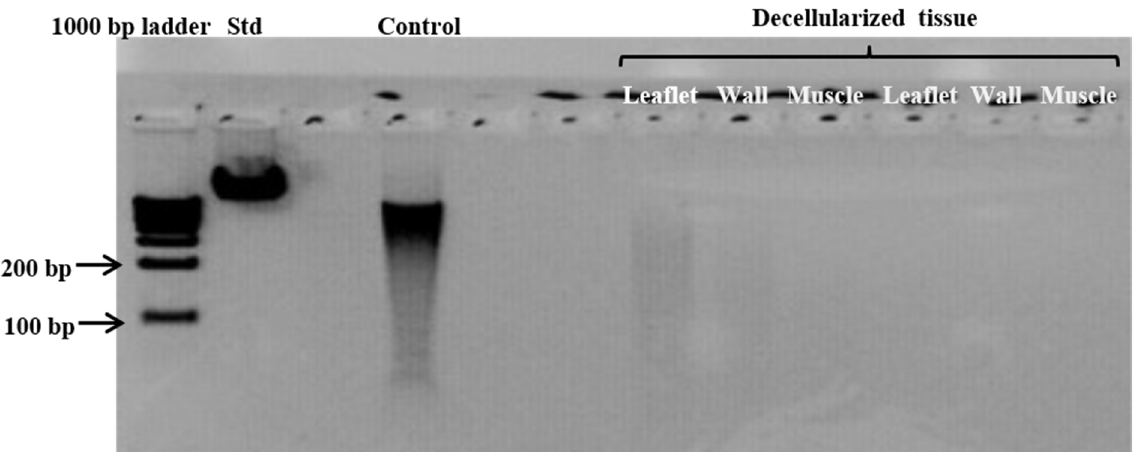
Figure 3. Representative gel electrophoresis image demonstrating the absence of DNA material in leaflet, wall, and muscle tissue of homografts after decellularization. (Standard (Std) = Lamba DNA; control = fresh homograft